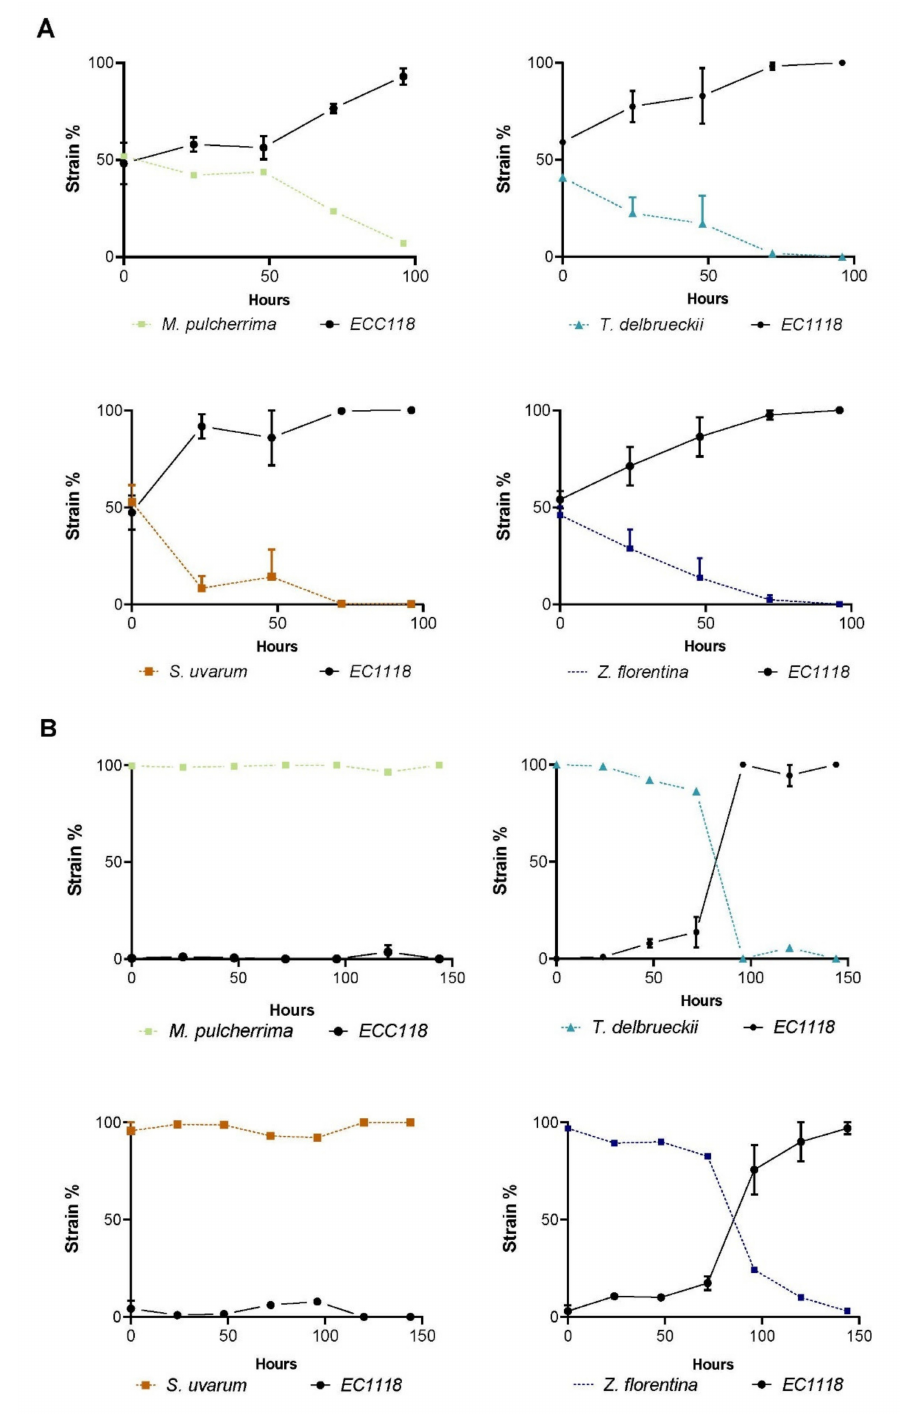
Figure 6. Competition experiment between commercial strains versus natural isolates. The relative percentage of the reporter commercial strain EC1118 (black line) in competition with each of the other FF strains inoculated in ( A ) equal proportions and ( B ) 1:100